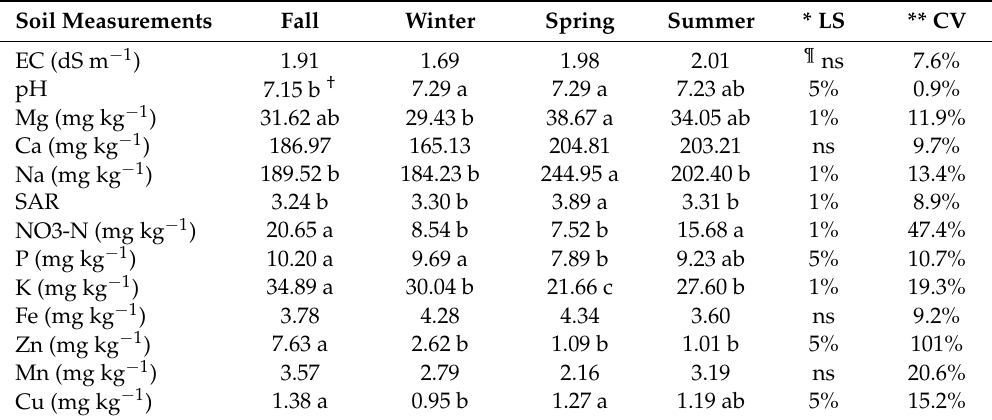
Table 3. Mean separation and coefficient of variation of soil chemical measurements at different sampling